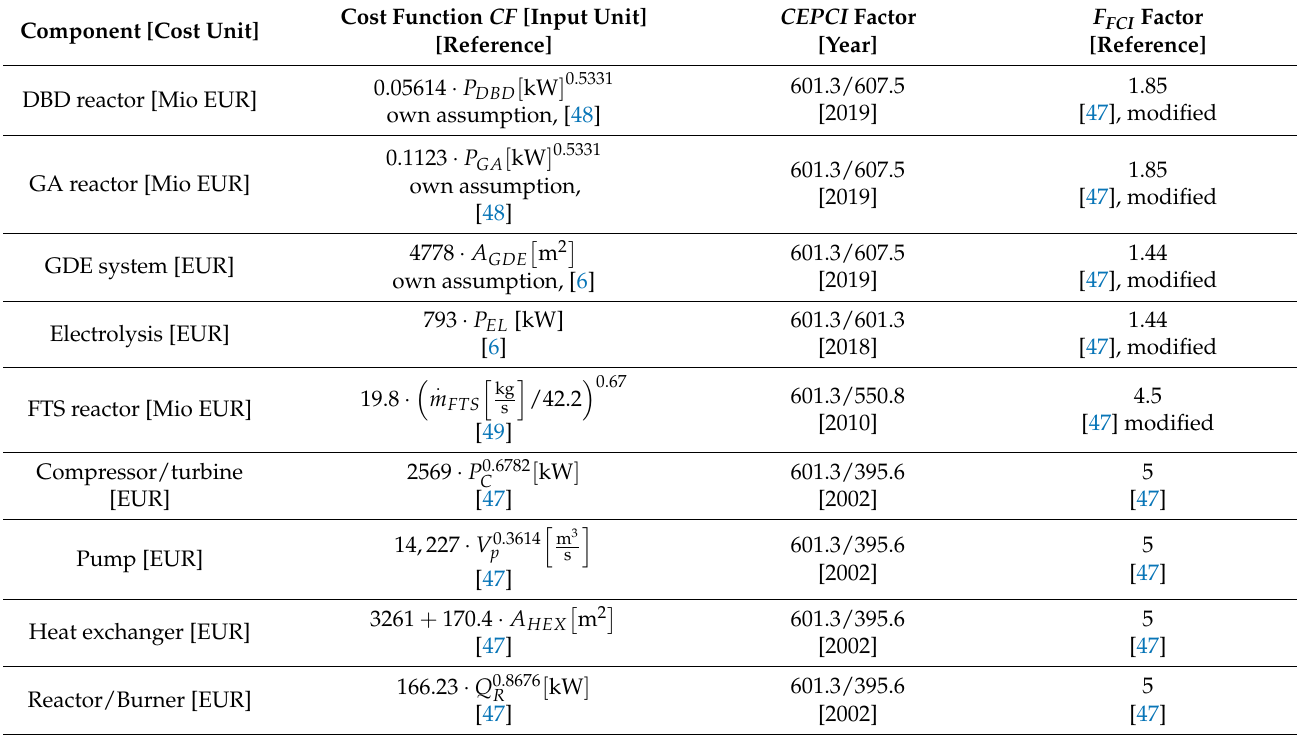
Table 4. Cost functions and cost factors for calculating the fixed capital investments (FCI) of each